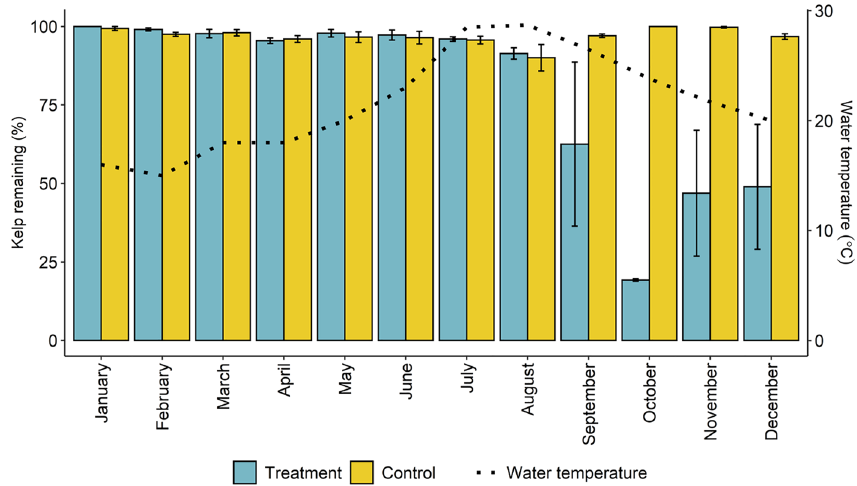
Figure 4. Monthly changes in the mean percentage remaining of the kelp biomass at Yokonami in 2018. The number of replicates is n = 3 for all months and for each treatment except October, where n = 2. Vertical bars indicate standard error. The broken line indicates the monthly change in seawater temperature during the experiment in each month at the study